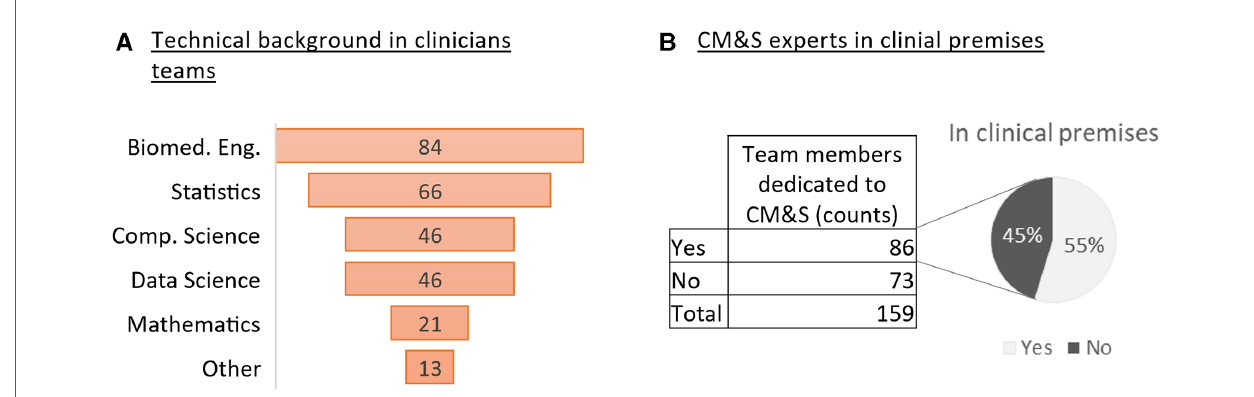
FIGURE 2 CM&S and technical expertise in clinical teams ( A ) Ranking of CM&S related backgrounds from the most represented to the less in the clinicians ’ teams (survey question #2) ( B ) Number of respondents who declares having team members dedicated to CM&S and percentage of them being based in clinical